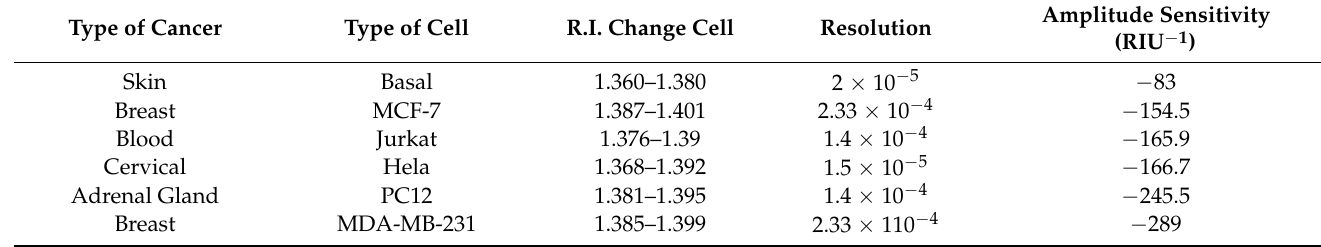
Table 2. Proposed PCF-SPR biosensor’s sensitivity analysis.